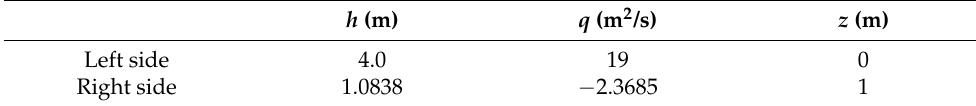
Table 5. Initial conditions for two hydraulic shocks (bores) propagating over a step.